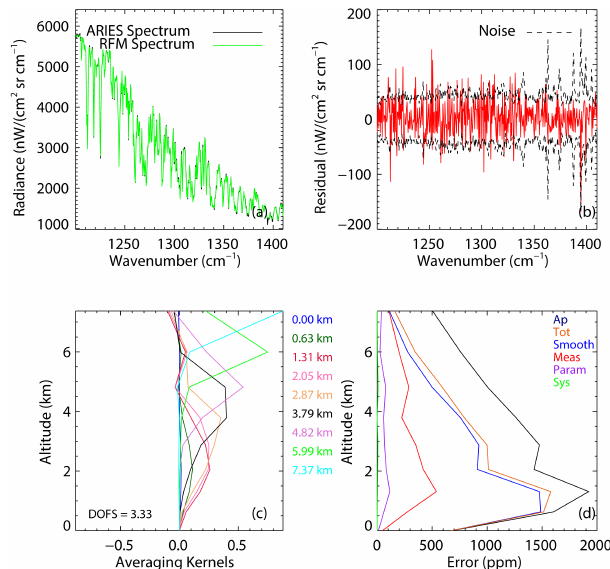
Figure 4. Example retrieval metrics for H 2 O during flight B290 over the Gulf of Mexico at 7.4km altitude showing (a) measured (ARIES, black) and fitted (green) spectra, (b) residual difference between the ARIES-measured and fitted spectrum (red) and noise- equivalent spectral radiance (NESR, black), (c) averaging kernels (and degrees of freedom for signal, inset), and (d) total and compo- nent systematic and random error